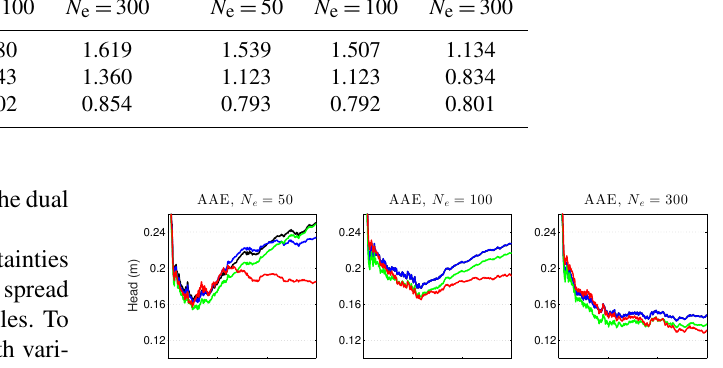
Table 4. Filter inbreeding indicator: Ratio of the mean average absolute error (AAE) and mean average ensemble spread (AESP) of the water head and the hydraulic conductivity for three different ensemble sizes. The reported values are given for the joint EnKF, dual EnKF, and the proposed dual EnKF OSA . Hydraulic head